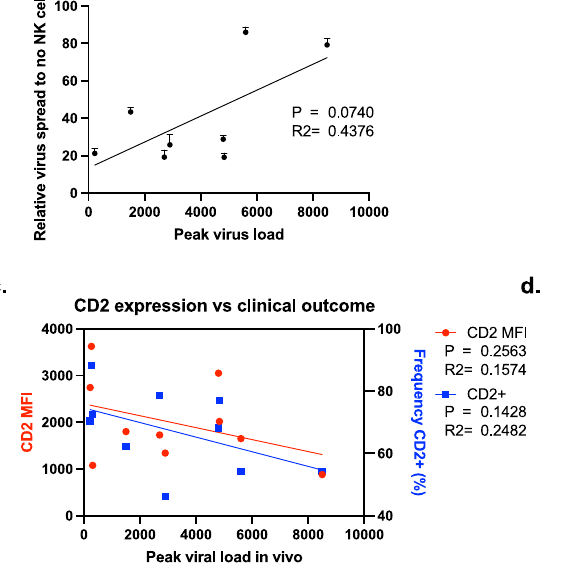
CD2 MFI (red)/frequency (blue) ( c ) or adaptive cNK (red) or lrNK (blue) cells ( d ) wasplottedagainst peakviralloadin vivo ( n =10).Signi fi cance wasassessedusing linear regression analysis with P values less than 0.05 considered signi fi cant. Source Data are provided as a Source Data fi